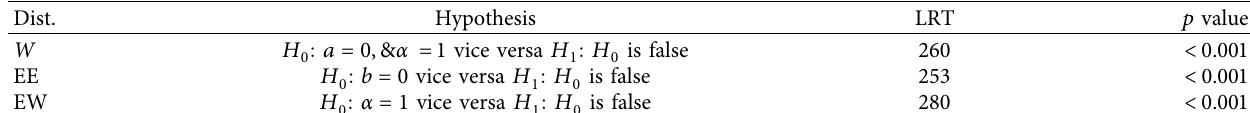
Table 9: The LRT statistic for the windshield data.